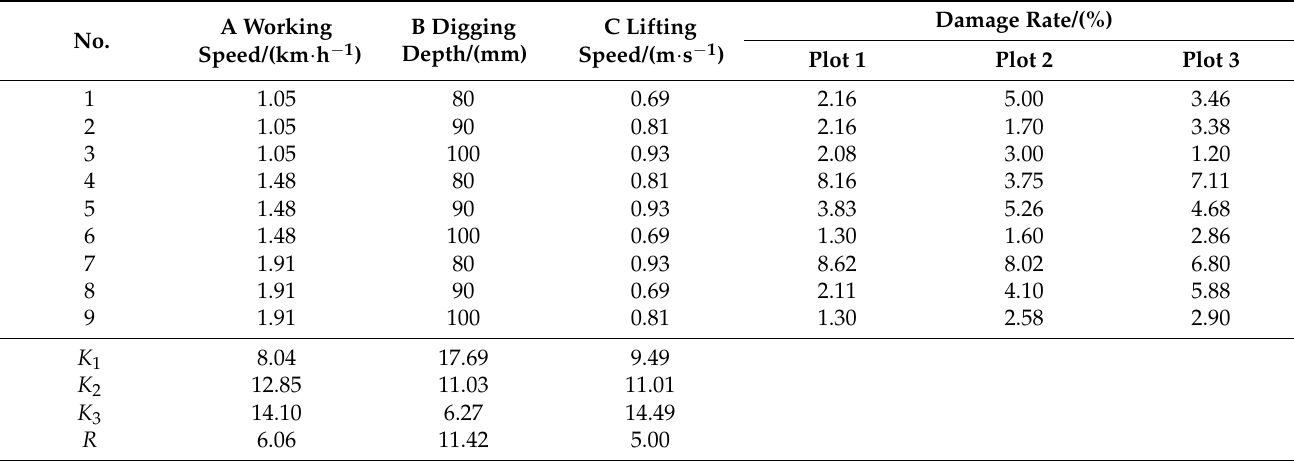
Table 4. Range analysis of orthogonal